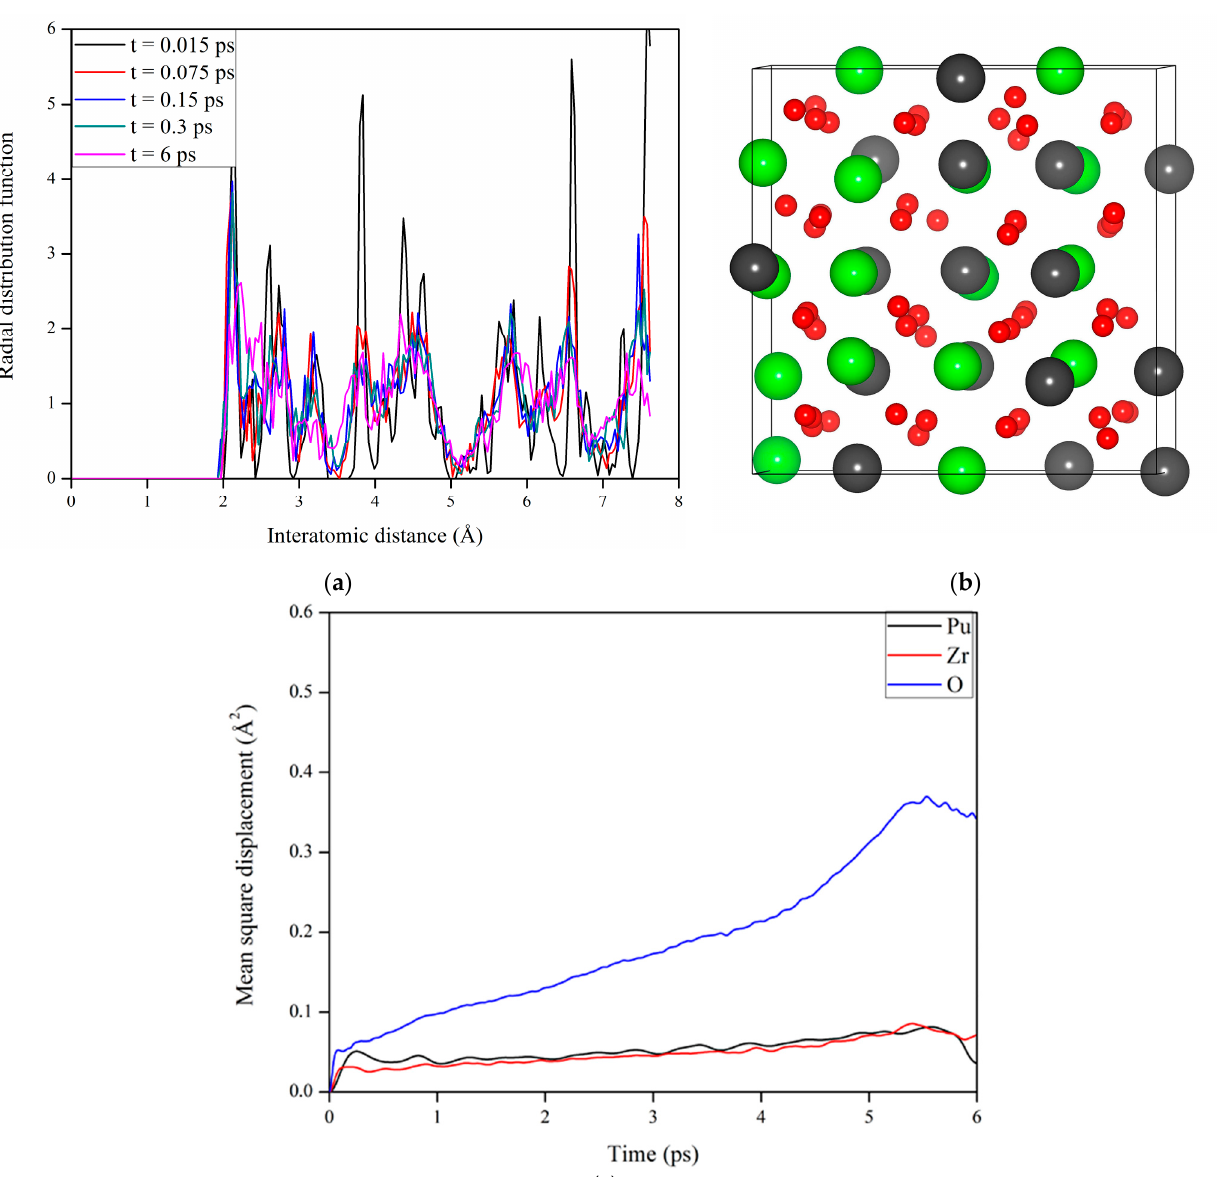
Figure 5. ( a ) Variation of radial distribution function (RDF) with time, ( b ) schematic view of the geometrical structure, and ( c ) variation of mean square displacement (MSD) with time for Pu 2 Zr 2 O 7 with 0.3% electron excitation.